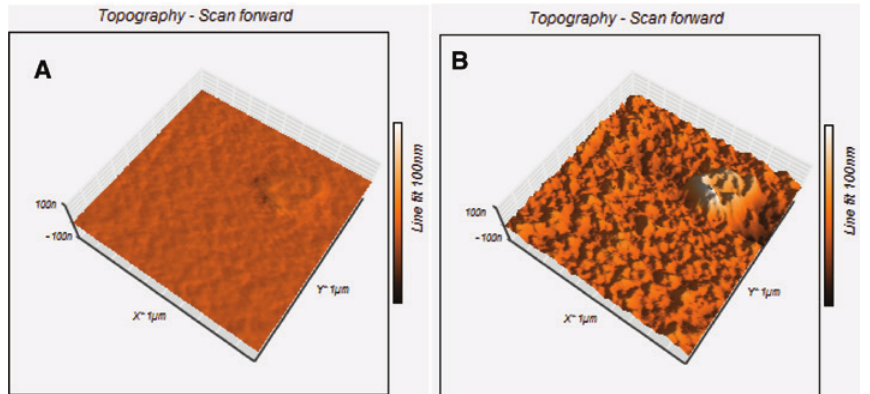
Figure 8: AFM images of premixed PVK:PBD:complex thin films with concentration ratios of 100:40:10 (A) and 100:40:20